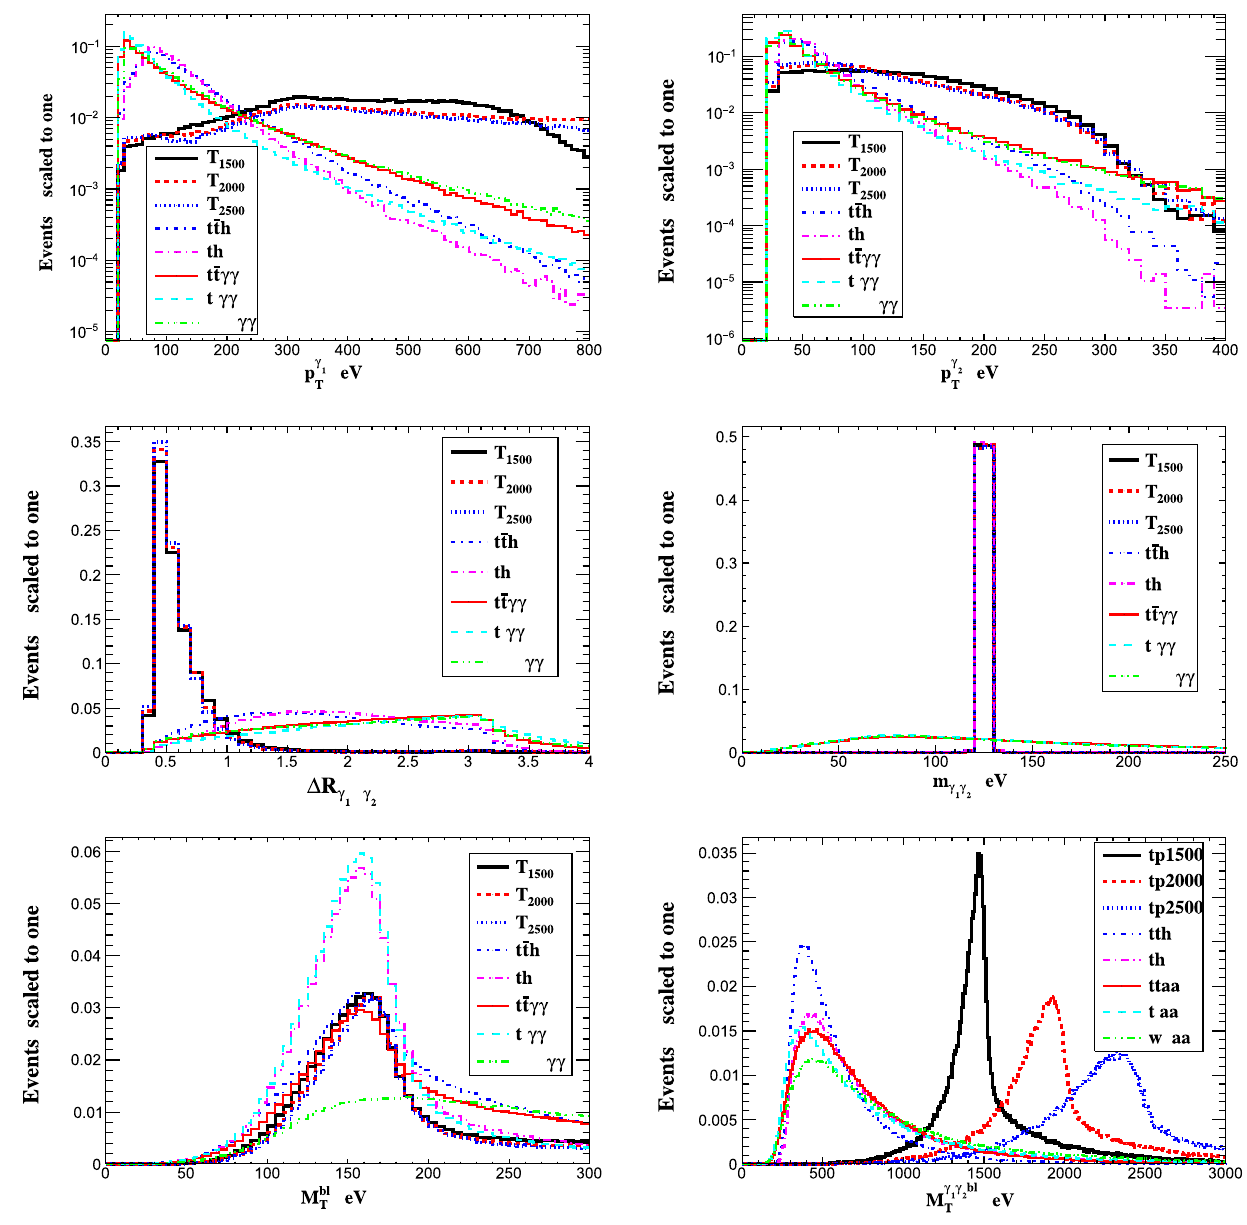
Fig. 3 Normalised distributions for the signals and SM backgrounds at LO for the HE-LHC at 27 TeV Table 1 The cut flow of the cross sections (in × 10 − 3 fb) for the signals and SM backgrounds at the HE-LHC with κ T = 0 . 1